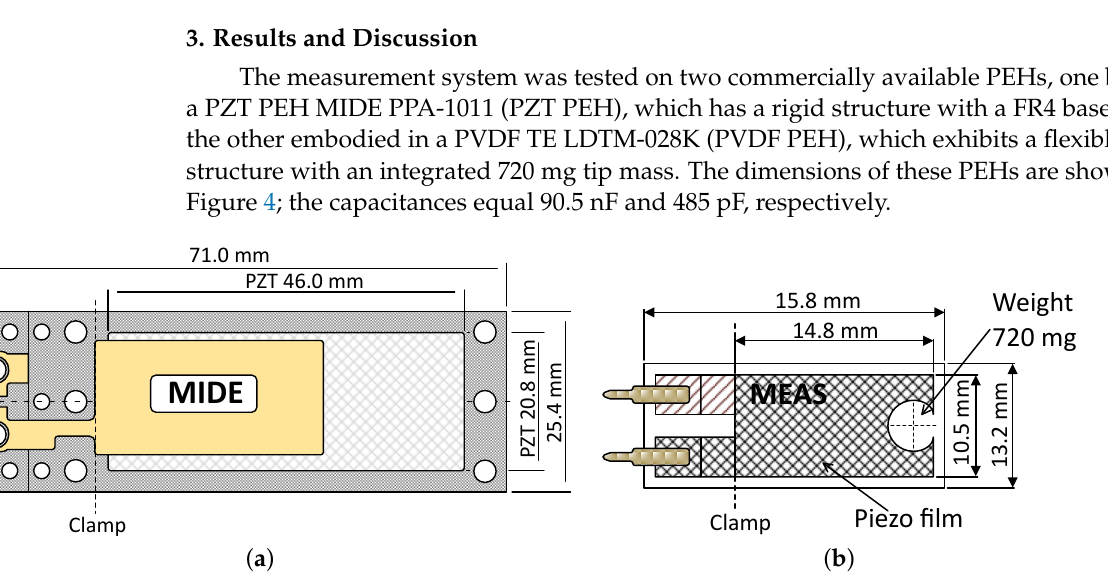
Figure 4. The tested PEHs: the MIDE PPA-1011 ( a ) and the TE LDTM-028K ( b ). Initially, each resonance frequency was found via the sine sweep, and then the vibra- tion mode (Figure 5) of the examined harvester was checked. The measured amplitudes enabled us to calculate the acoustic power corresponding to the aerodynamic drag. At the final stage, we carried out the same measurement cycles at different vibration ampli- tudes. The 3D proposed efficiency plots (side and top views) relating to selected vibration amplitudes are shown in Figure